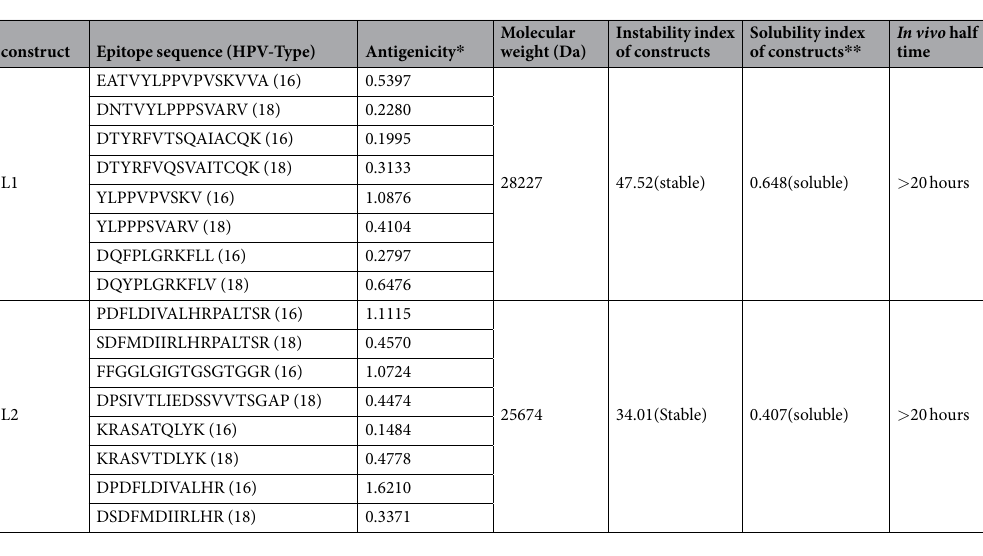
Table 15. Physicochemical properties of L1 and L2 DNA vaccine constructs. * higher rate shows high degree of peptide antigenicity. ** higher rate shows high degree of peptide